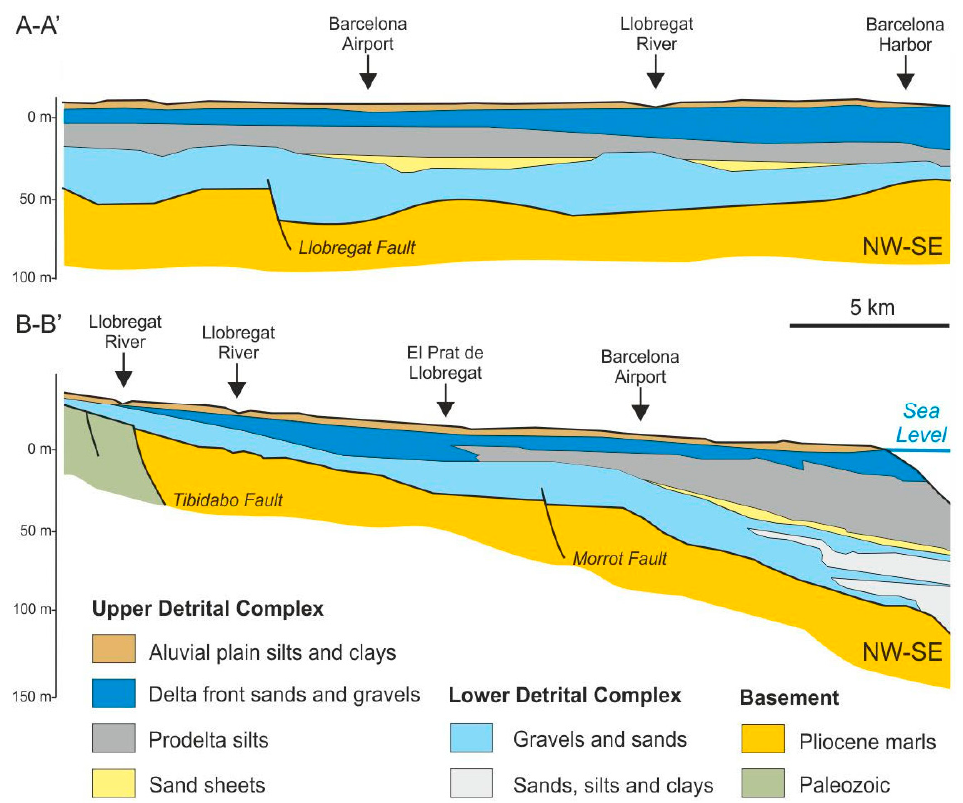
Figure 2. Geological sketch cross-sections of the LRD located in Figure 1 (( A - A ’) is SW–NE oriented; ( B - B ’) is NW–SE oriented), modified and updated from MOP [35], Marqués [11], Simó et al. [20], Gámez et al. [7].